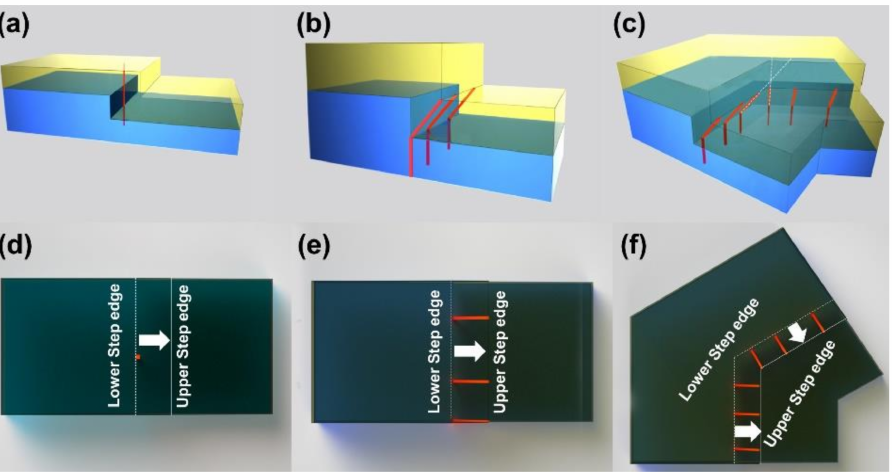
Figure 6. ( a – c ) Bird’s-eye-view and ( d – f ) plan-view schematic diagram of dislocation evolution for TSG-AlN with monoatomic step, straight macro-step, and zigzag macro-step morphologies. Reprinted with permission from [42]. Copyright {2021} American Chemical